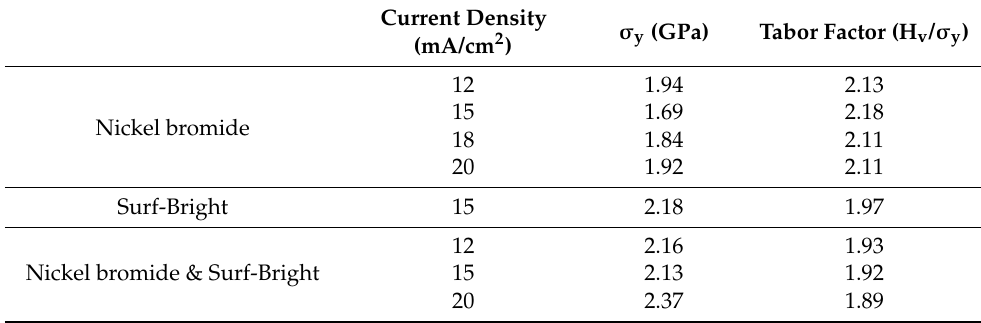
Figure 5. SEM image of the deformed micro-pillars fabricated from the nickel–cobalt alloys electro- deposited with the bath containing ( a – d ) nickel bromide, ( e ) the Surf-Bright, or ( f – h ) both nickel bromide and the Surf-Bright, and at a current density of ( a , f ) 12 mA/cm 2 , ( b , e , g ) 15 mA/cm 2 , ( c ) 18 mA/cm 2 and ( d , h ) 20 mA/cm 2 . Table 2. Summary of the yield strength and Tabor